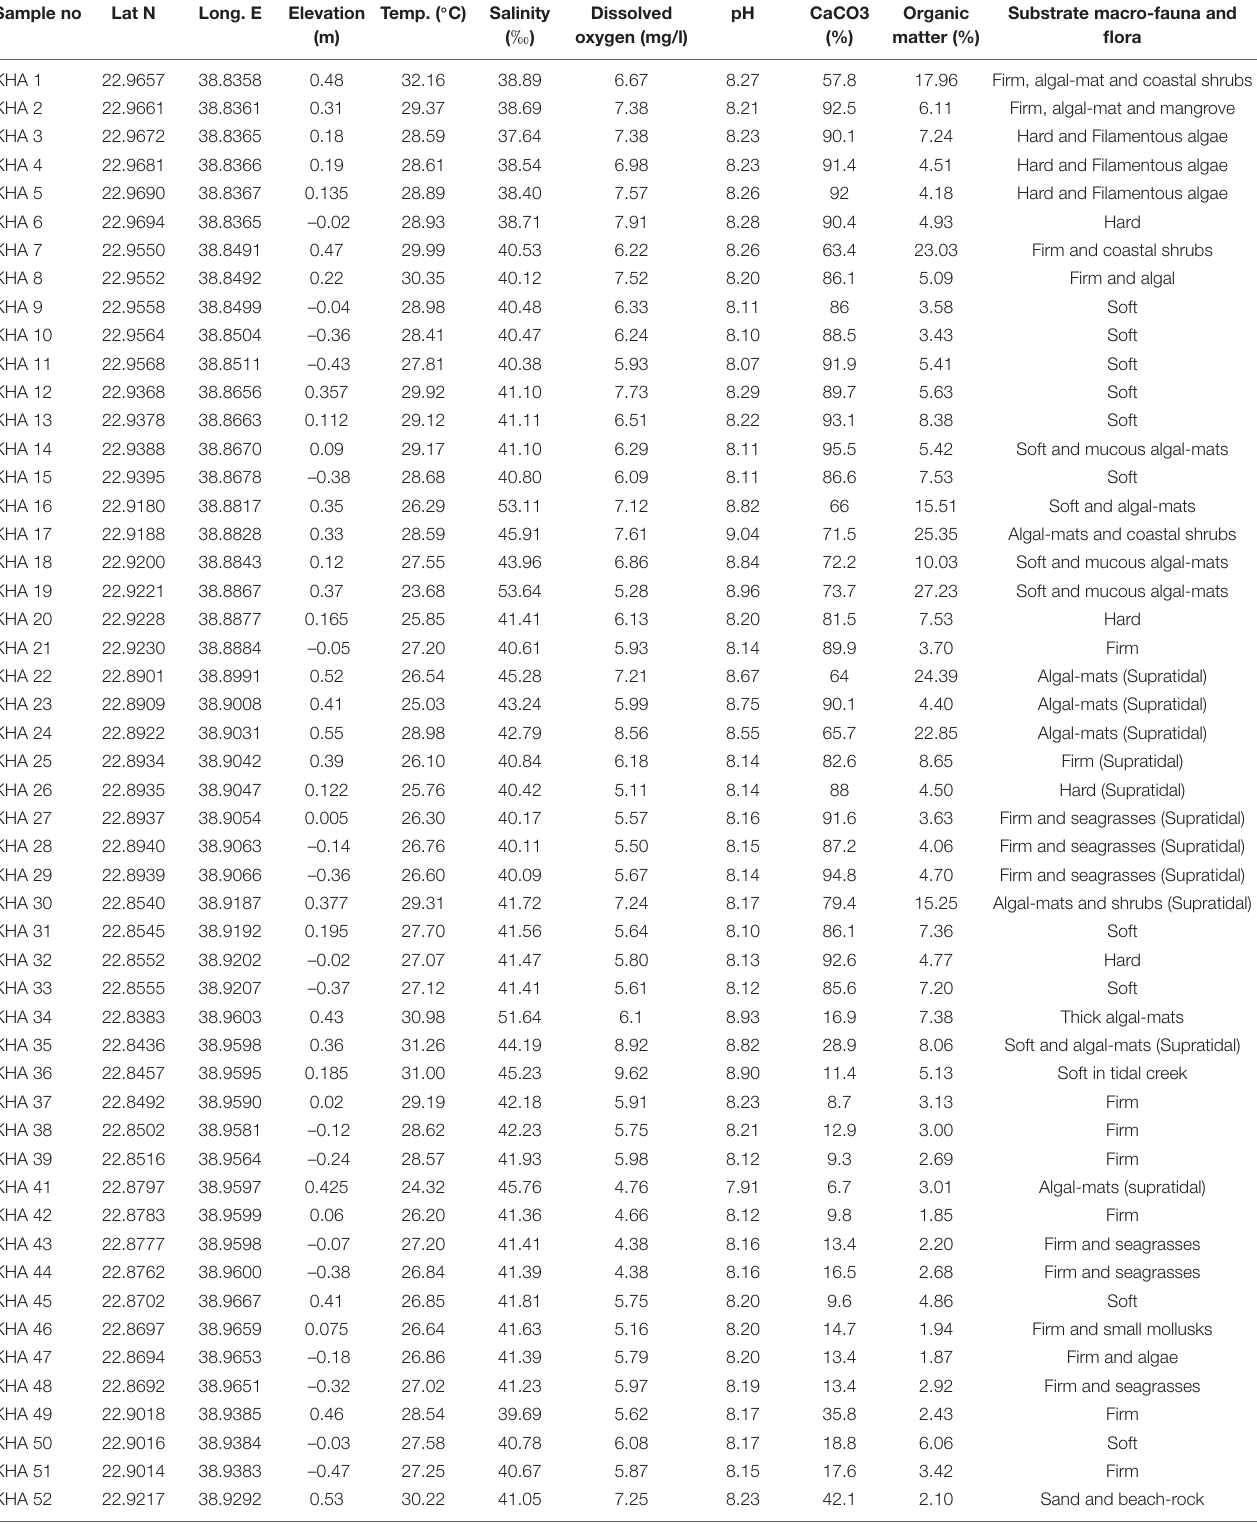
TABLE 1 | Sample sites, elevations, physico-chemical parameters, and carbonate and organic matter contents in surface sediments of Al-Kharrar Lagoon during March 2014 (modified after Al-Dubai et al., 2017a,b). Sample no Lat N Long. E Elevation (m)